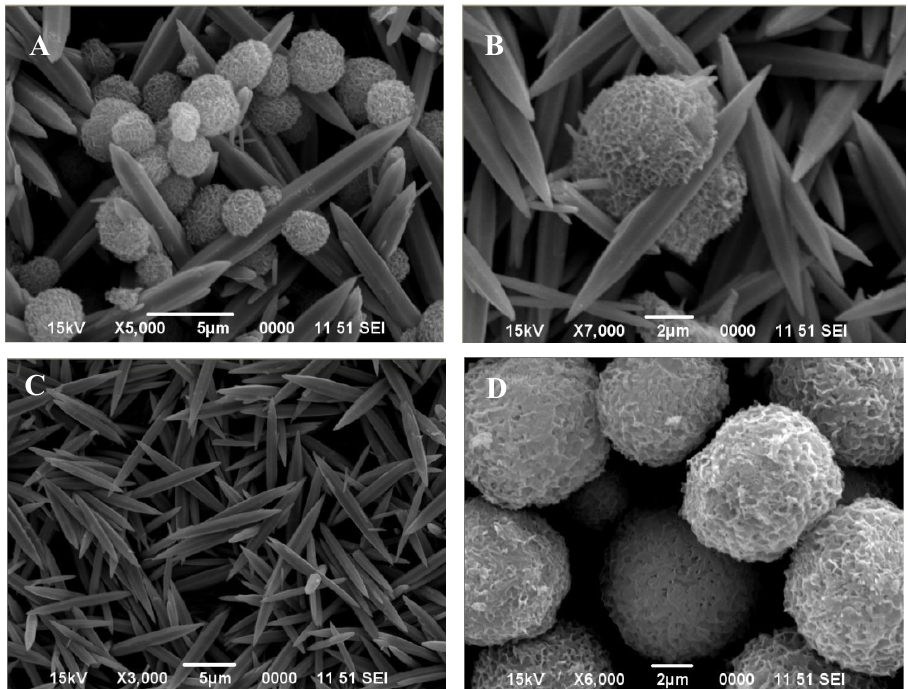
Figure 2. SEM images of the particles precipitated from a mixture, containing 0.4 mol/L urea, 0.035 mol/L zinc nitrate and 10 vol.% ethylene glycol. The mixture was heated to boiling under reflux for: 50 min ( A and B ) and 20 min ( C ). ( D) obtained by reflux